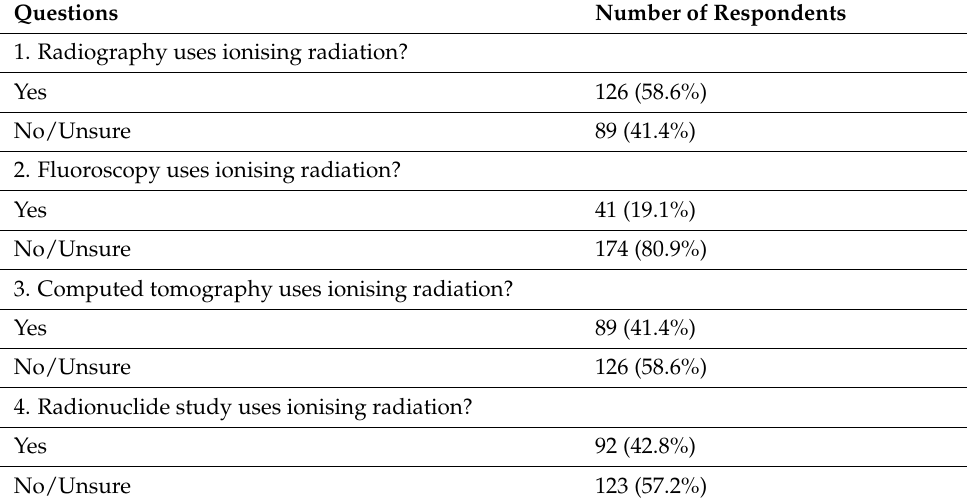
Table 2. Questionnaire responses on ionising radiation-related medical imaging. It can be seen that 58.6% of the respondents ( n = 126) know that radiography is associated with ionising radiation. For other medical imaging such as fluoroscopy, CT, radionuclide study and angiography, more than 50% of the respondents did not realise these modalities involve the utilisation of ionising